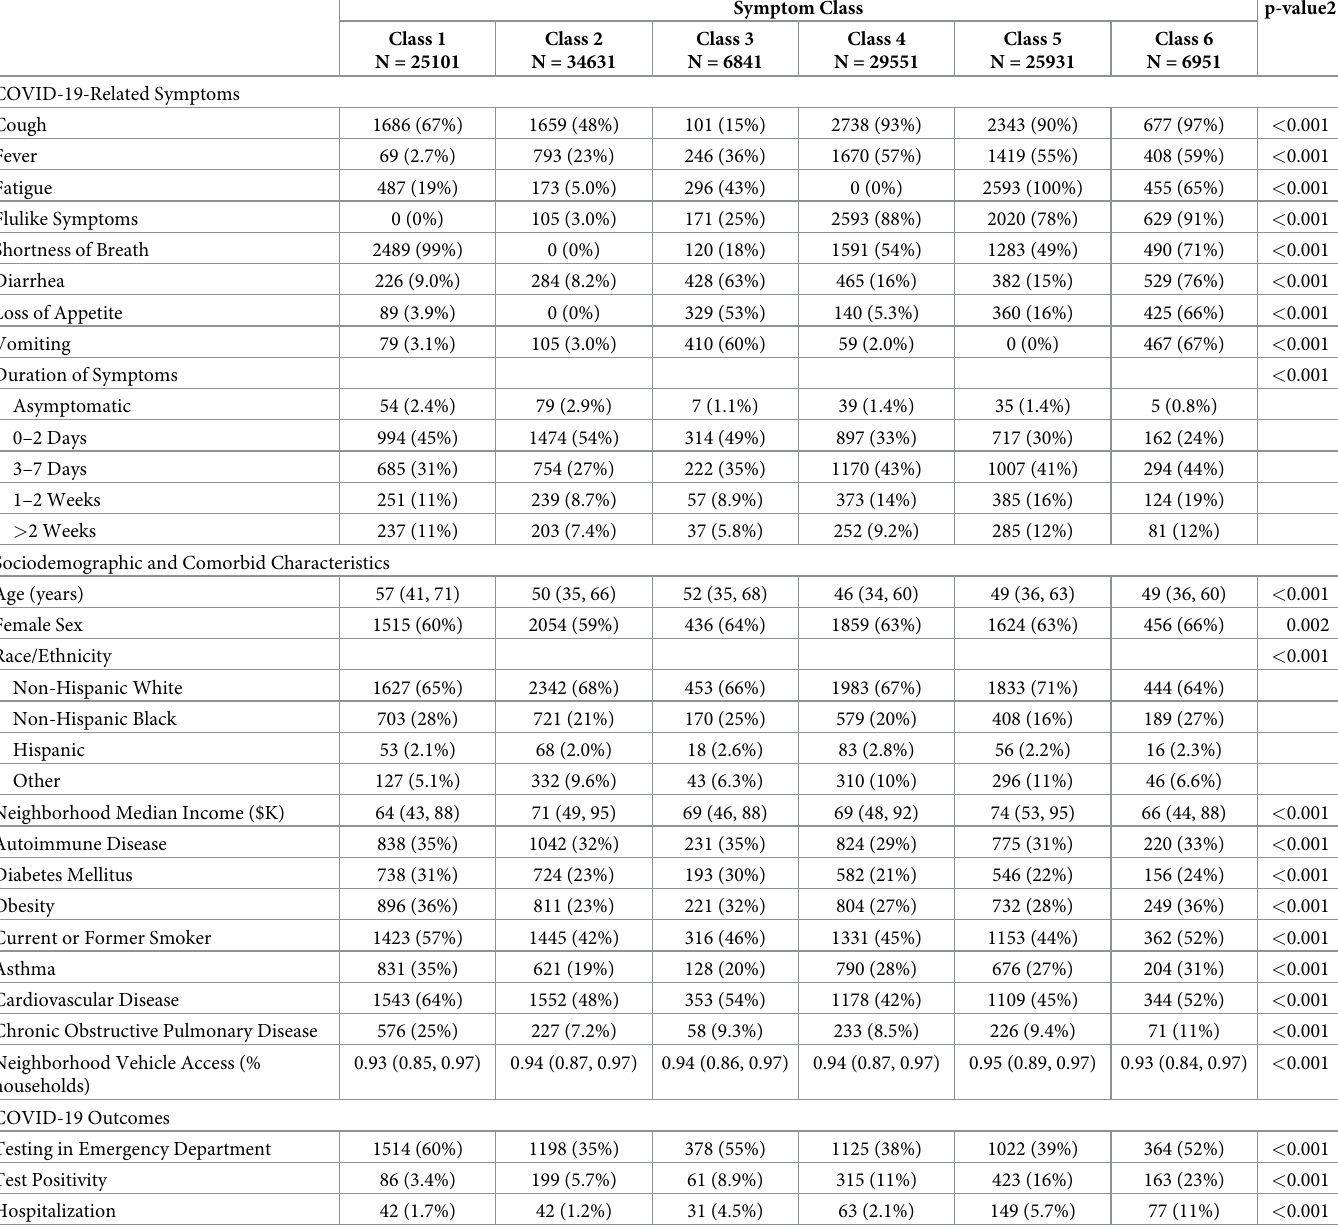
Table 2. Sociodemographic and clinical characteristics; and COVID-19 screening and clinical outcomes; stratified by symptom class. Patients were assigned to symptom classes based on their modal estimated probability of class membership derived from the latent class